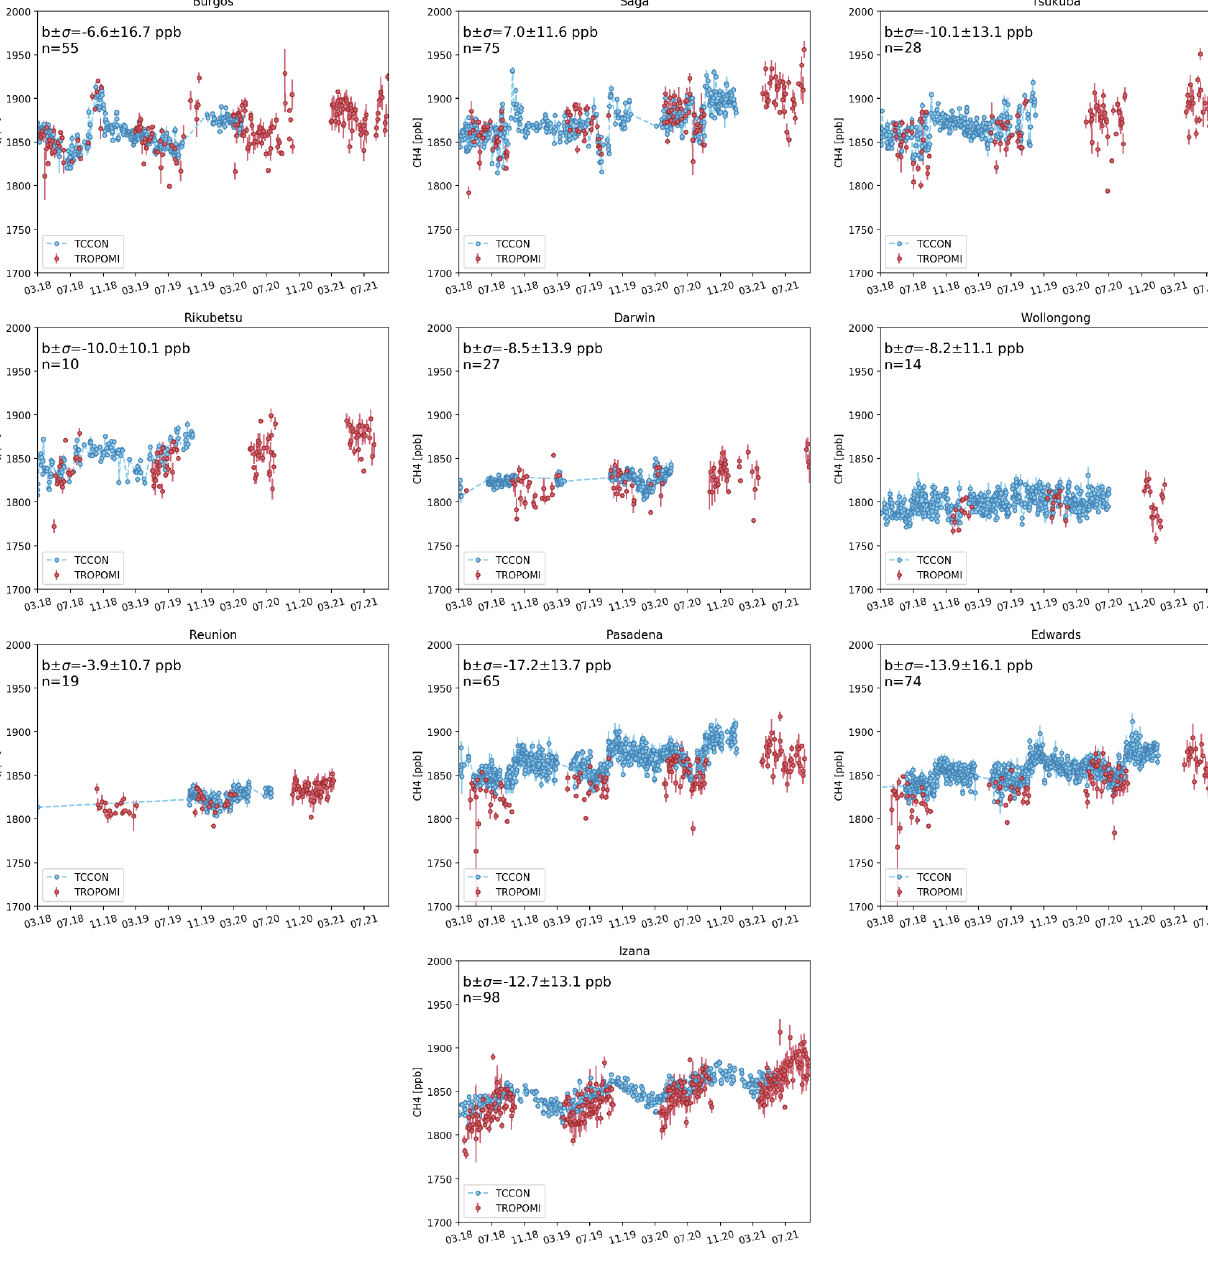
Figure 4. Time series of daily averaged XCH 4 measurements from TCCON (blue) and TROPOMI over ocean for sun glint geometry (red) collocated with the selected stations for the period 1 March 2018–1 October 2021. TROPOMI measurements over ocean for sun glint geometries around a circle of 300km radius around each station have been selected for the